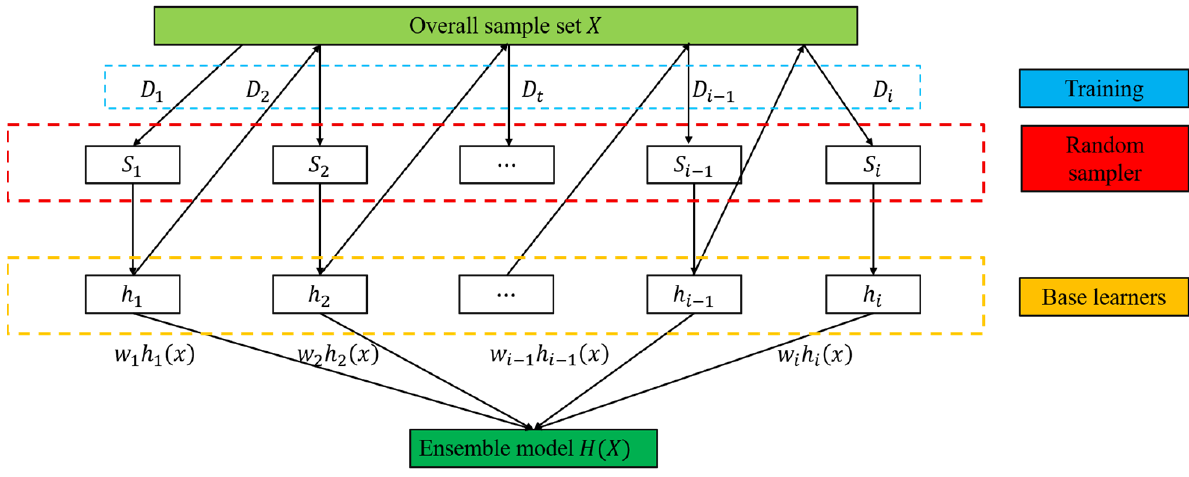
Figure 2. Boosting Flow Chart.